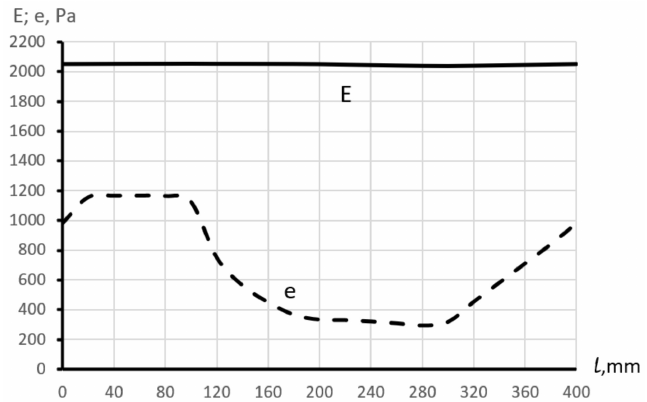
Figure 23. Graphs of changes in the partial pressure of water vapor e and partial pressure of saturated water vapor E in the area of metal structures that are not in contact with the attic air for calculation scheme without a gusset plate (thermal insulation—mineral wool with a density of 200 kg/m 3 and a thickness of 100